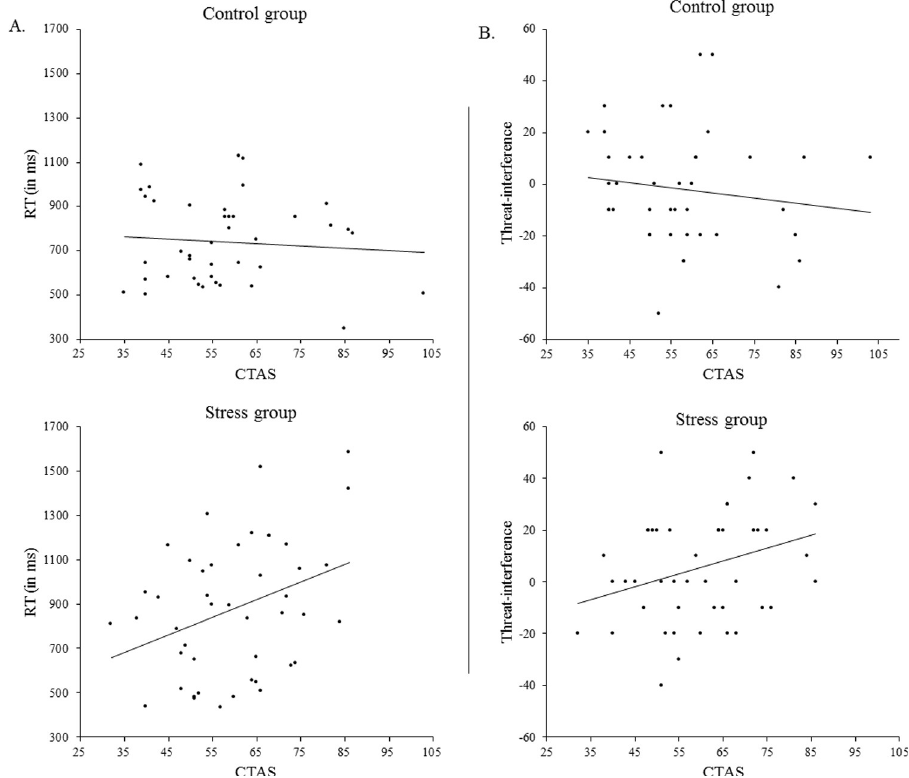
Fig 4. Scatterplots for the relationship between CTAS and n -back performance in the control and stress groups. A) Scatterplots for the relationship between CTAS and RT during the blank condition in the control (upper panel; r = -.08, p = .618) and the stress group (lower panel; r = .35, p = .02). B) Scatterplots for the relationship between CTAS and threat-interference during the high load condition as assessed by accuracy (accuracy scores during neutral condition. minus accuracy scores during negative evaluation condition in %) in the control (upper panel; r = -.138, p = .388) and the stress group (lower panel; r = .312, p = .037).